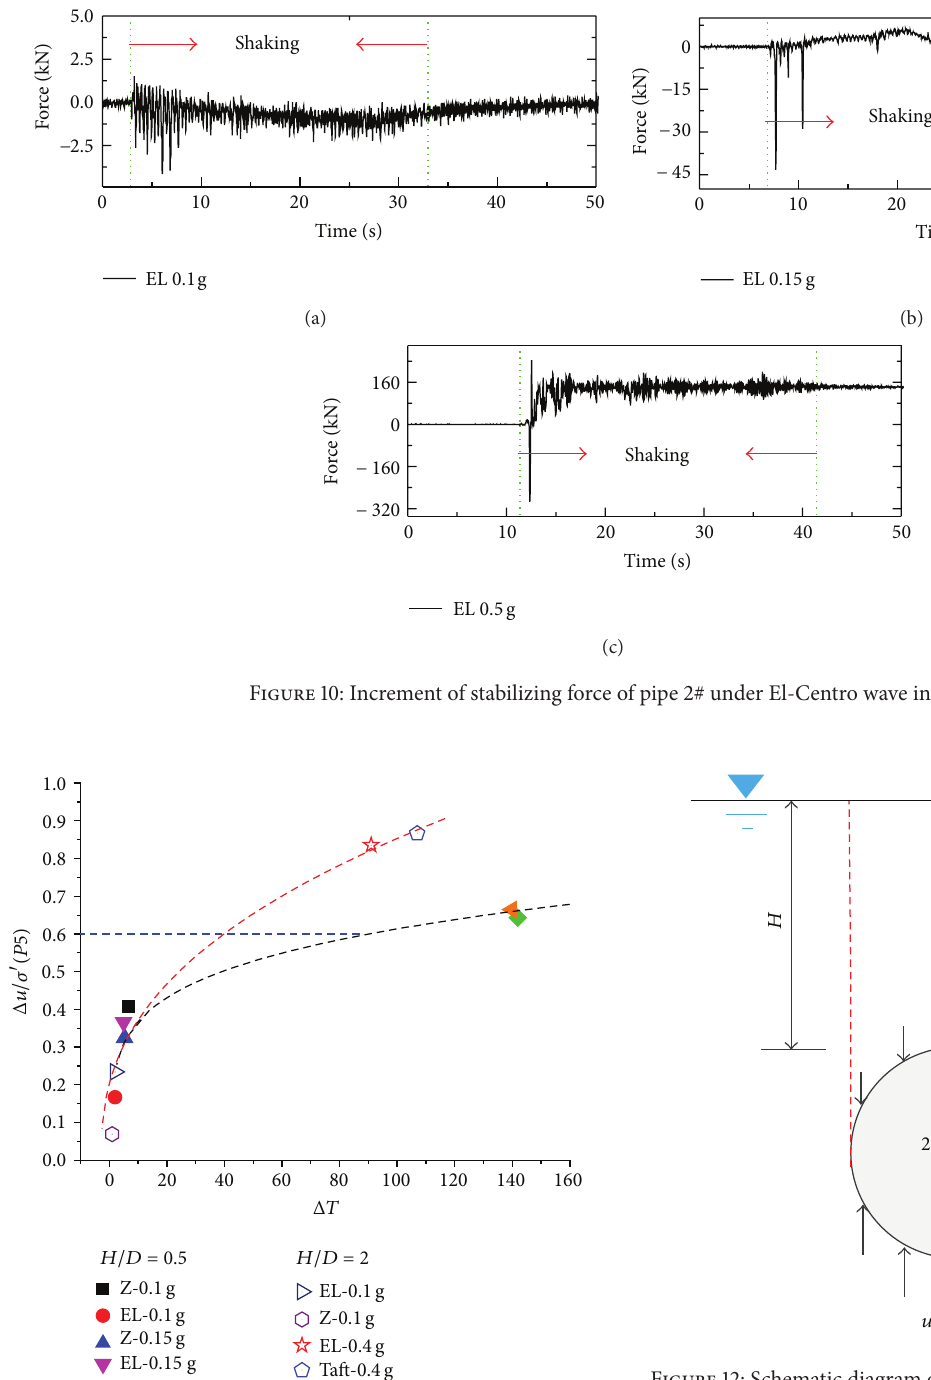
Figure 12: Schematic diagram of force of pipe 2# before